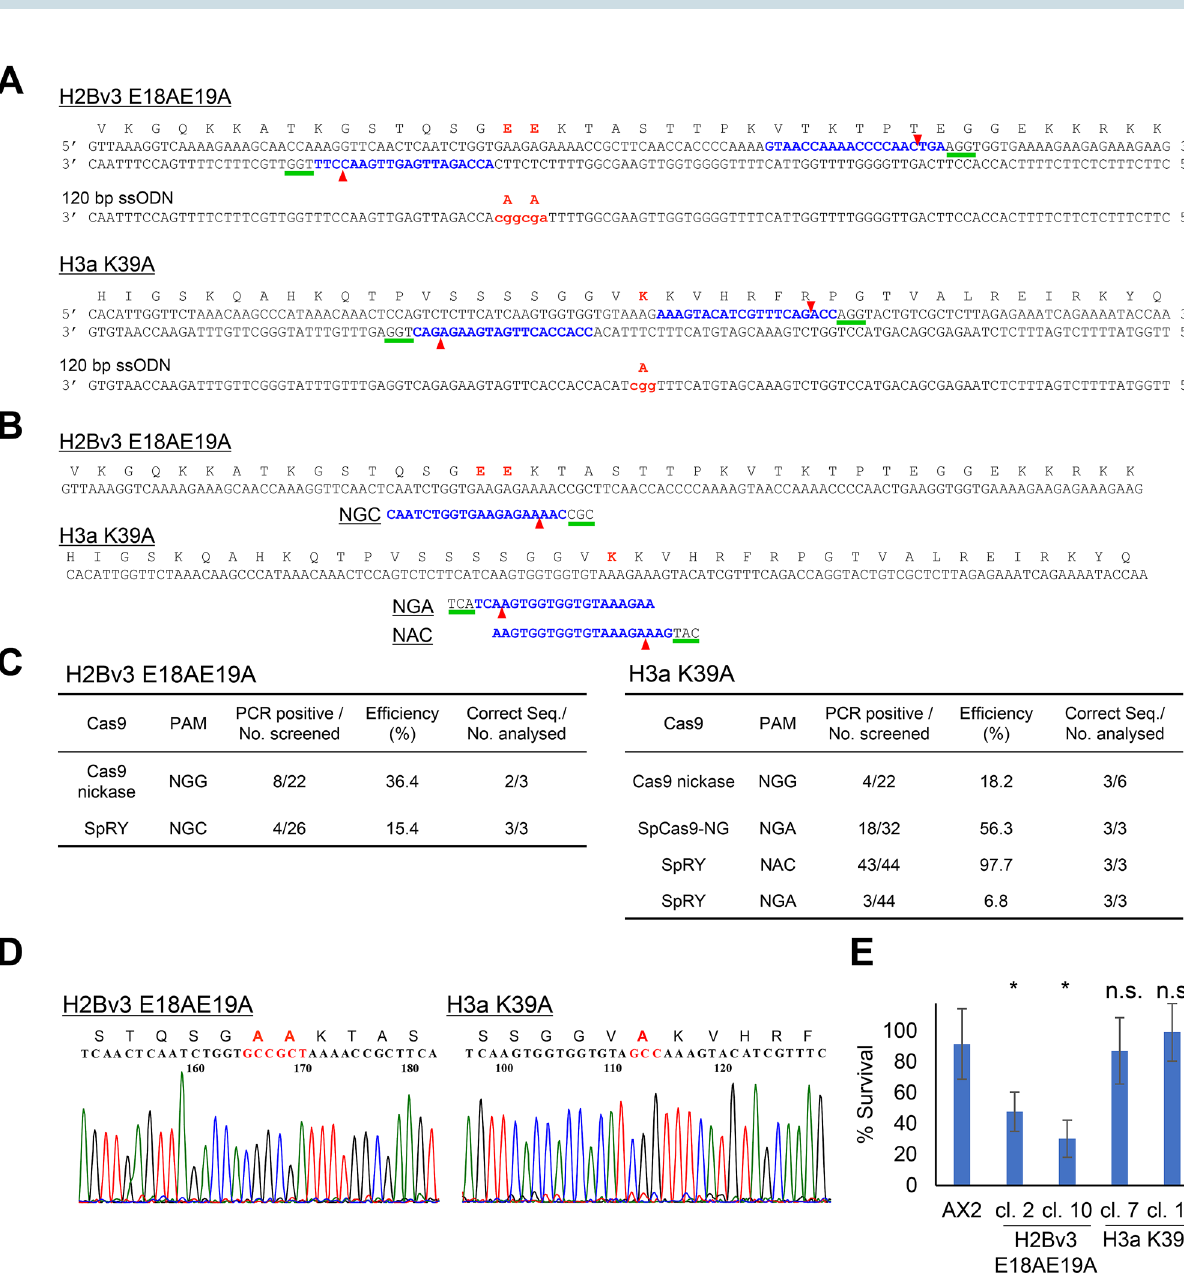
Figure 5. Precise nucleotide substitution mediated by double nicking and SpRY. ( A ) A pair of sgRNAs and ssODN for double-nicking. Point mutations are indicated by red letters. ( B ) Target sequences used for SpRY. Three targets with different PAMs are shown. ( C ) Summary of point mutation frequencies with the indicated CRISPR/Cas9 systems. ( D ) Sequencing chromatogram of each cell line. Mutated nucleotides and amino acids are shown in red. ( E ) Cell viability in response to phleomycin. Results are expressed as the percentage of point-mutated clones that survived. Error bars indicate S.D. of three biological replicates. * P < 0.001; n.s., not significant; Student’s t-test. n = 4 biological